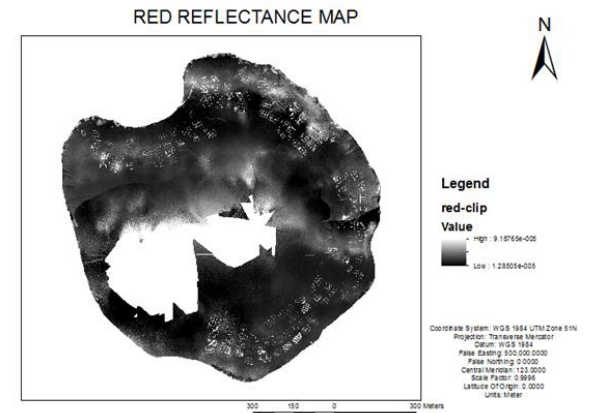
Figure 2: Green reflectance map